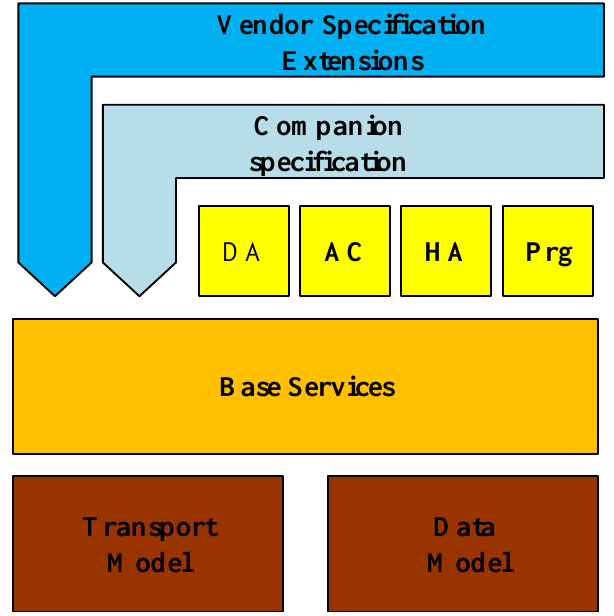
Figure 7. OPC UA